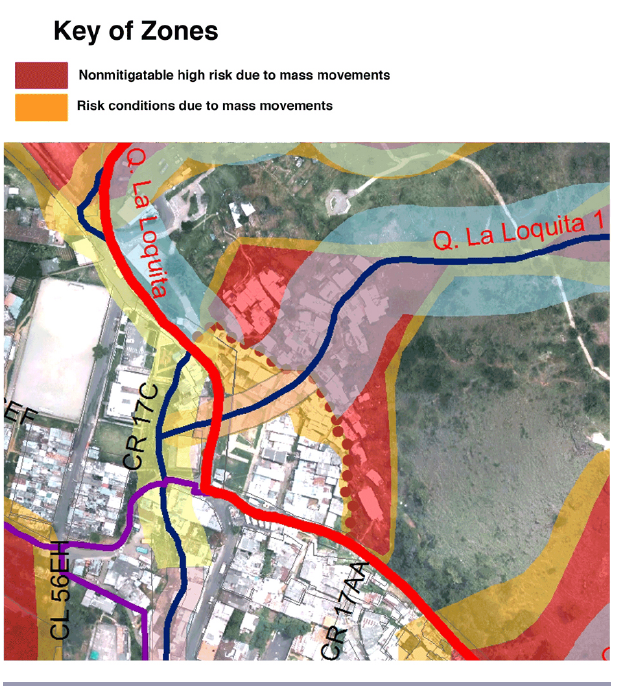
Fig. 4 . Risk zones in Pinares de Oriente. Source: adapted from Empresa de Desarrollo Urbano and SIGA